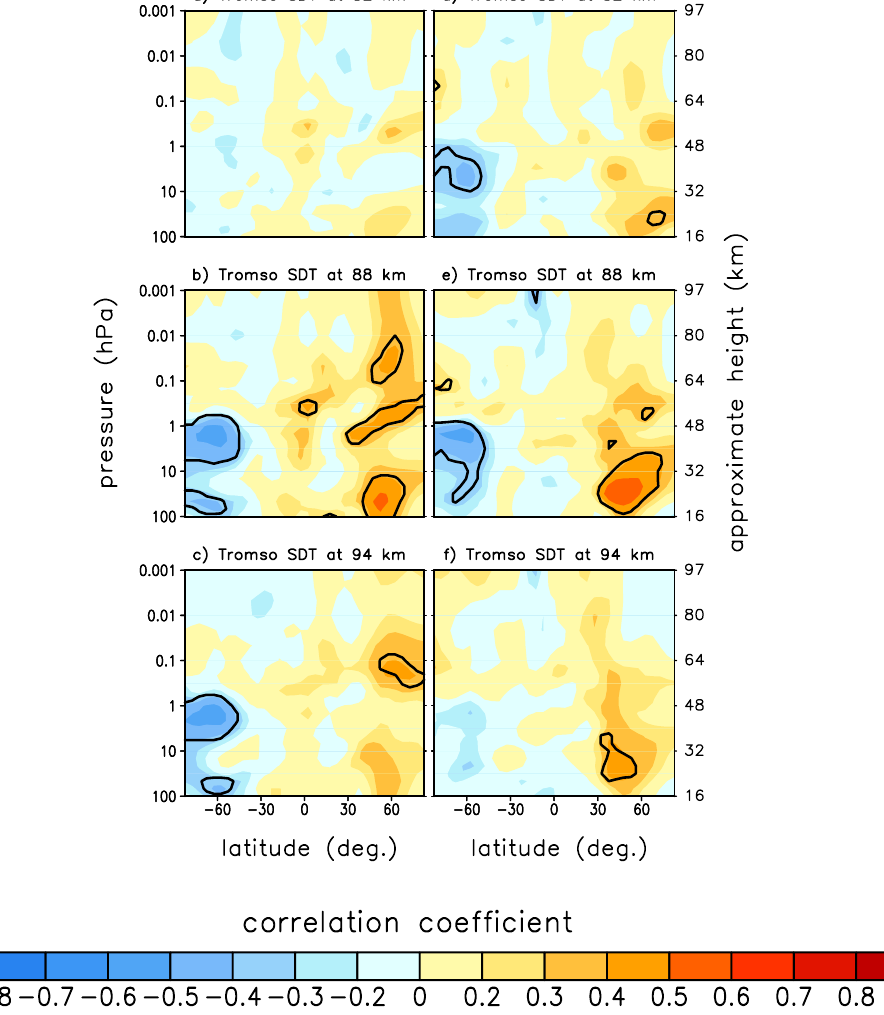
Fig. 8. Correlation coefficients between the stationary planetary wave 1 amplitude at each latitude/pressure with the meridional semidiurnal tide amplitudes observed at Tromsø for 7 November–6 March 2006/2007 (left column) and for 7 November–5 March 2007/2008 (right column). Otherwise details are as in Fig.